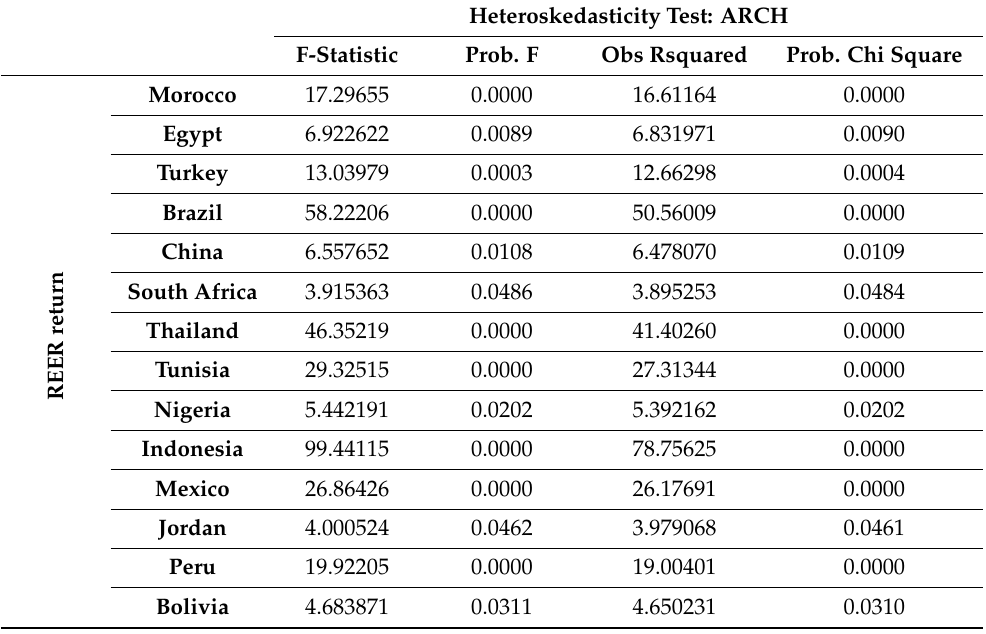
Table 5. The ARCH heteroskedasticity test results.